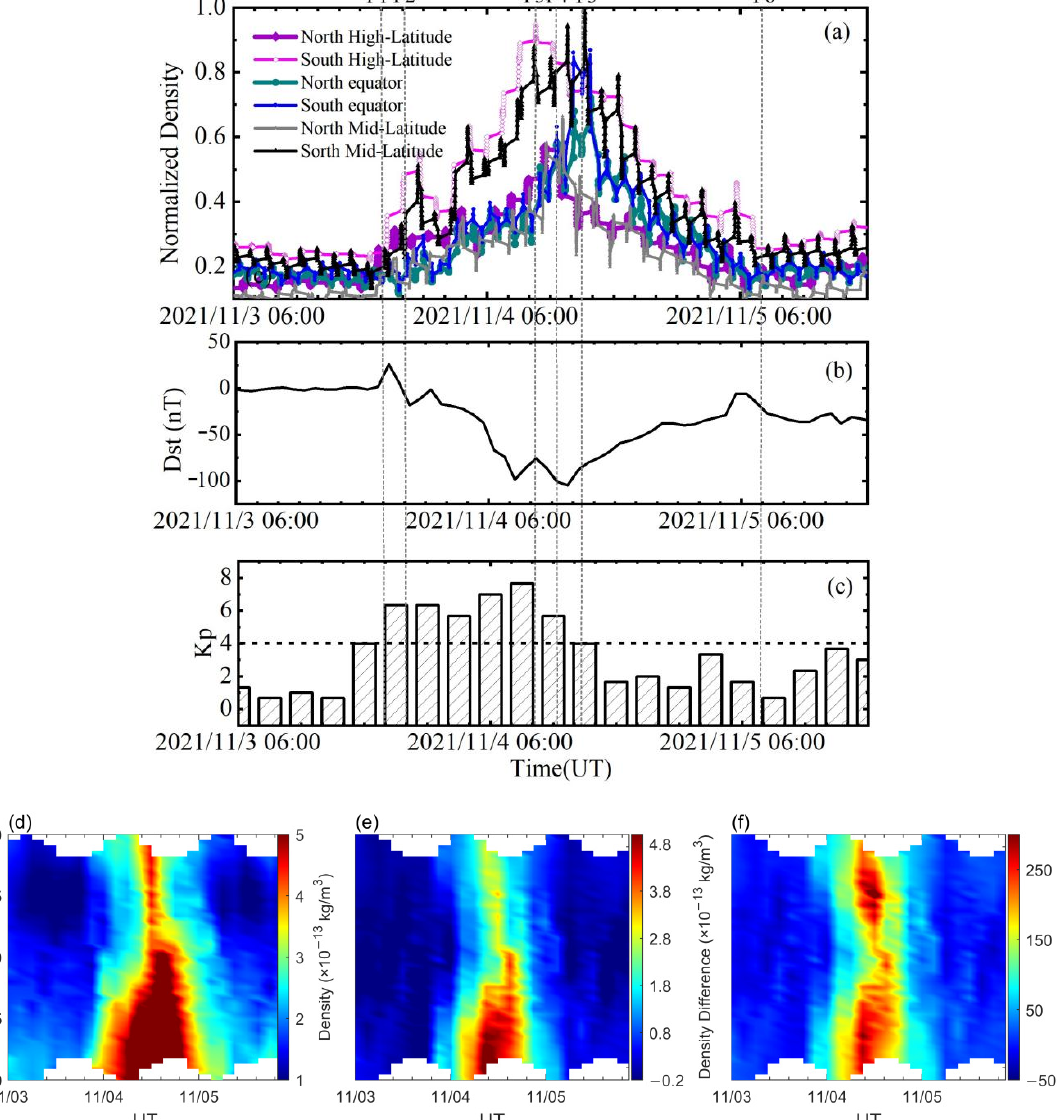
Figure 4. Time evolution and distribution of atmospheric density during the geomagnetic storm: ( a ) normalized atmospheric density at different geomagnetic latitudes; ( b ) Dst index; ( c ) Kp index; ( d ) absolute value of atmospheric density; ( e ) absolute change of atmospheric density; ( f ) relative variation of atmospheric density.